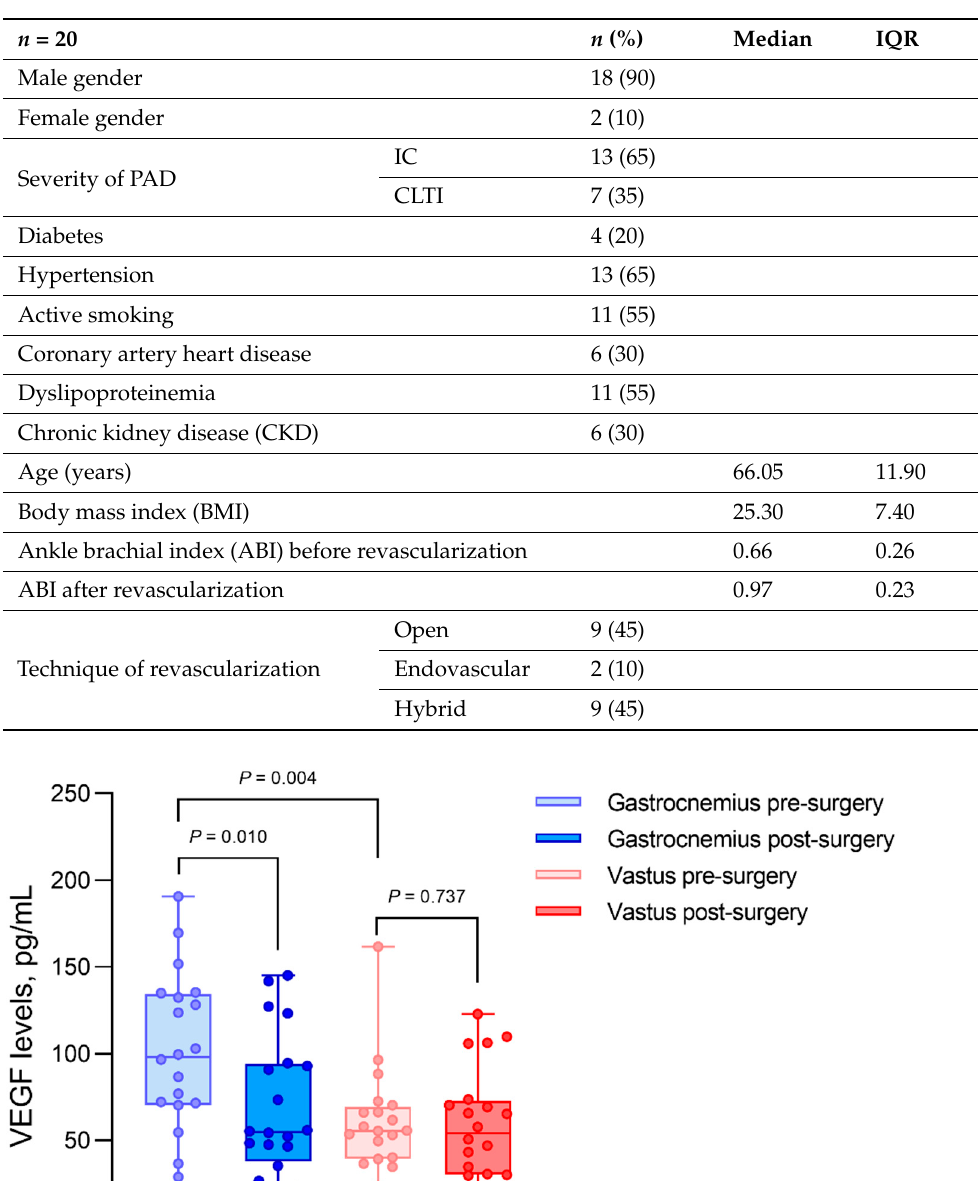
Table 1. Patient characteristics, cardiovascular risk factors, and surgical techniques. IQR: interquartile range. PAD: peripheral artery disease. IC: intermittent claudication. CLTI: chronic limb-threatening ischemia.